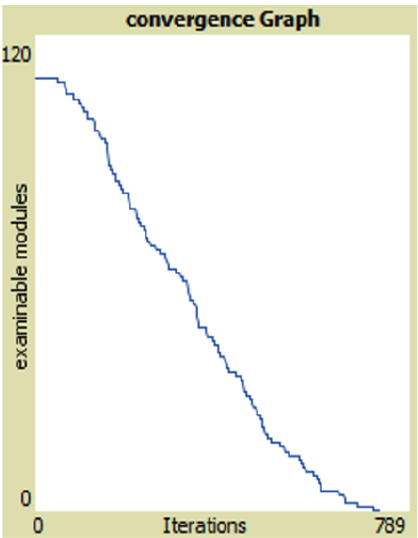
Figure 10: Number of Iteration (100